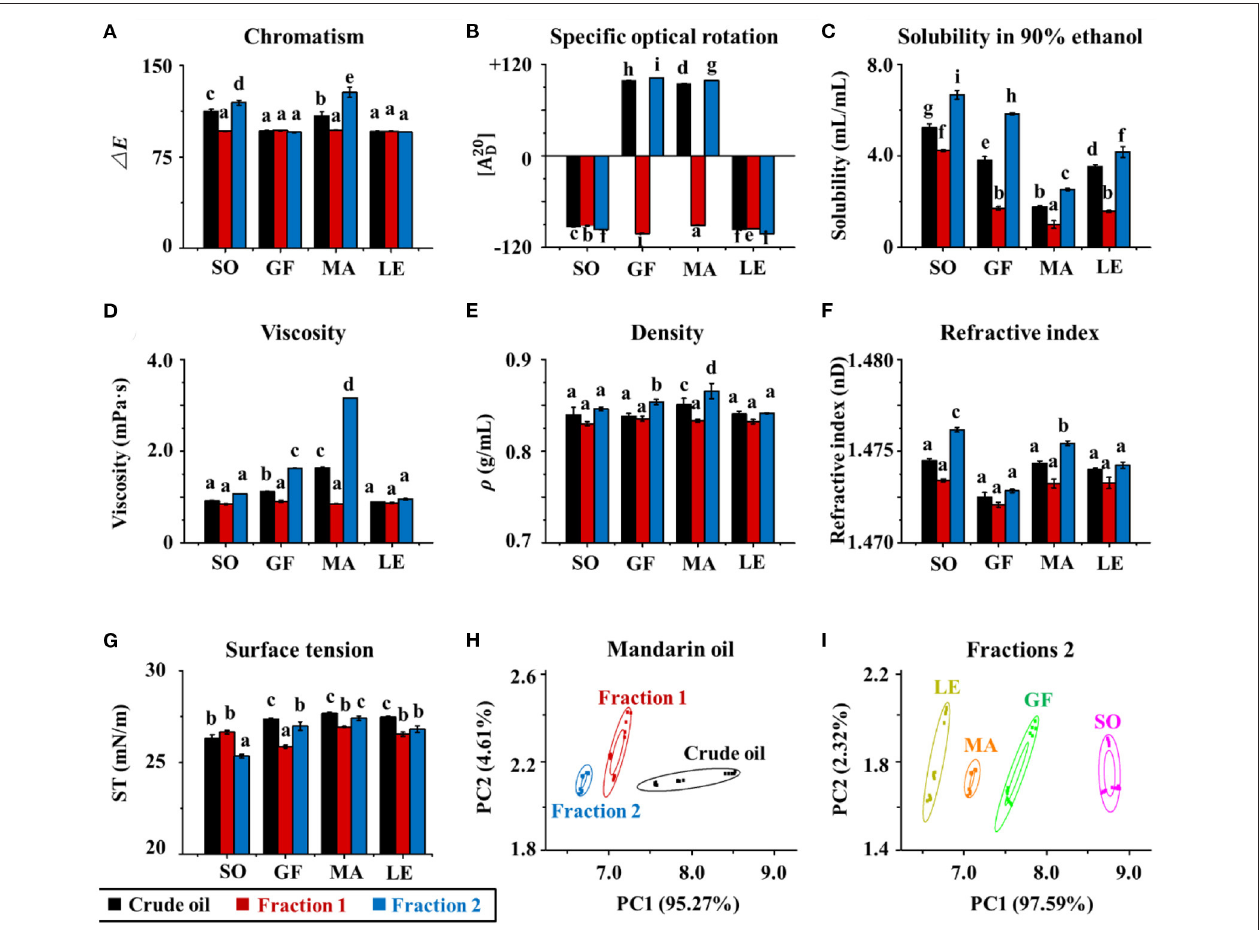
FIGURE 4 | (A) Color, specific, (B) optical rotation, (C) solubility in 90% ethanol, (D) viscosity, (E) density, (F) refractive index, and (G) surface tension of crude essential oils (CEOs) and Fractions 1 (F1) and 2 (F2) of SO, GF, MA, and LE. (H) Electronic nose analyses (PCA) of crude EOs and Fractions 1 and 2 of MA oil. (I) Electronic nose analyses of Fractions 2 of SO, GF, MA, and